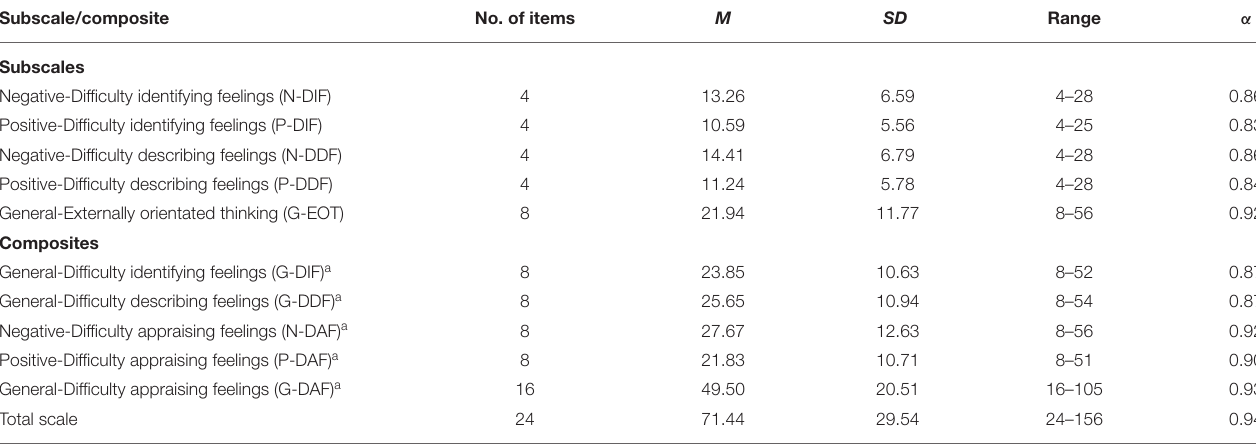
TABLE 3 | Descriptive statistics and Cronbach’s α reliability coefficients for the Perth alexithymia questionnaire. Subscale/composite No. of items M SD Range